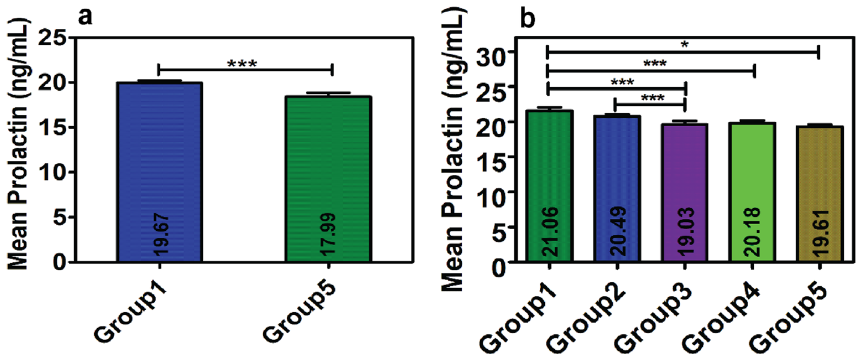
Figure 2. Distribution of mean serum prolactin levels and statistical comparison for different groups in ( a ) Phase 1 and ( b ) Phase 2 study. [Results are expressed as mean ± SD; statistical significance denoted by ‘*’ corresponds to p value of < 0.05 and ‘***’ corresponds to p < 0.001].